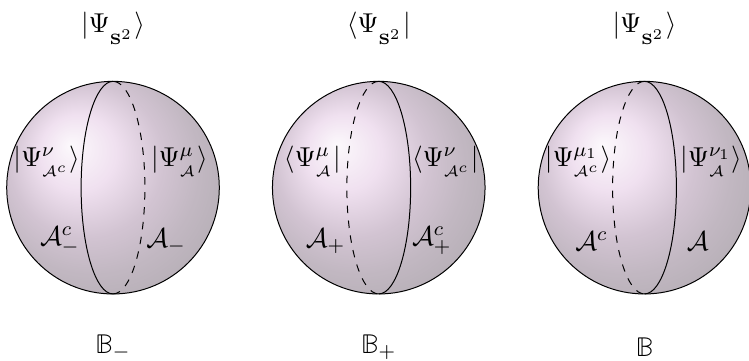
Figure 7 . The action of (cid:26) on the state j (cid:9) i can be captured by performing the path integral A S 2 over three 3-balls, B (cid:0) , B + , and B with the following identi(cid:12)cations: region A c region A + identi(cid:12)ed with A . The net result is a path integral over a single 3-ball whose boundary consists of two complementary regions A (cid:0) and A c . 3-balls, B , B , and B which make up the reduced density matrix and the state j (cid:9) (cid:0) +